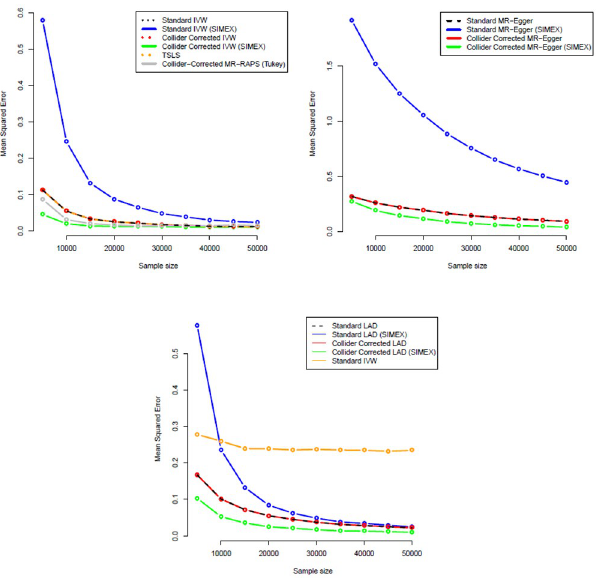
Fig 9. Mean Squared Error for all IVW (A = top-left), MR-Egger (B = top-right) and LAD regression (C = bottom) estimators.